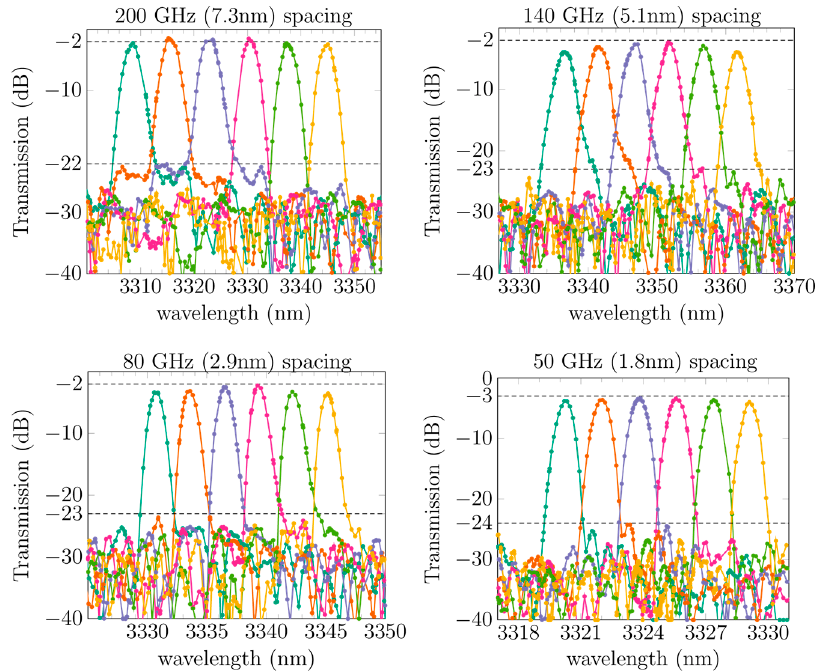
Figure 13. Transmission of four different SOI AWGs operating in the 3.3 μ m wavelength range with different channel spacing. The insertion loss (2–3 dB) and crosstalk levels (20–21 dB) are indicated by the dashed lines. The high-resolution (50 GHz) AWG can be used as a mid-infrared DFB laser array multiplexer.